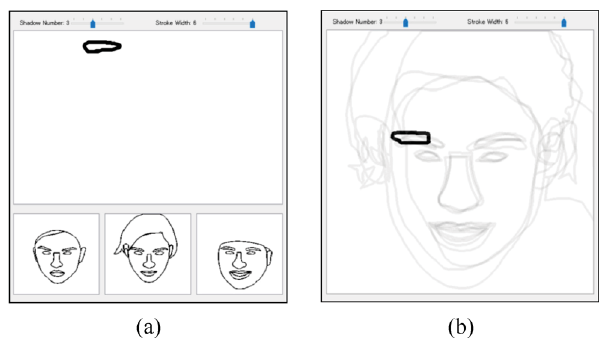
Fig. 5 Drawing interfaces used in our user study: (a) suggestive drawing UI and (b) shadow drawing